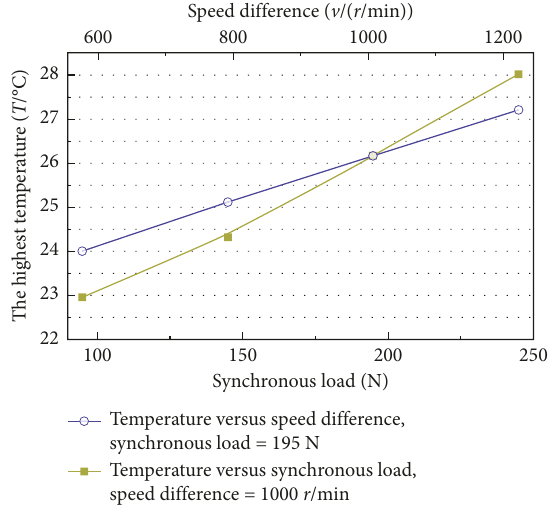
Figure 10: Variation law of temperature under different working